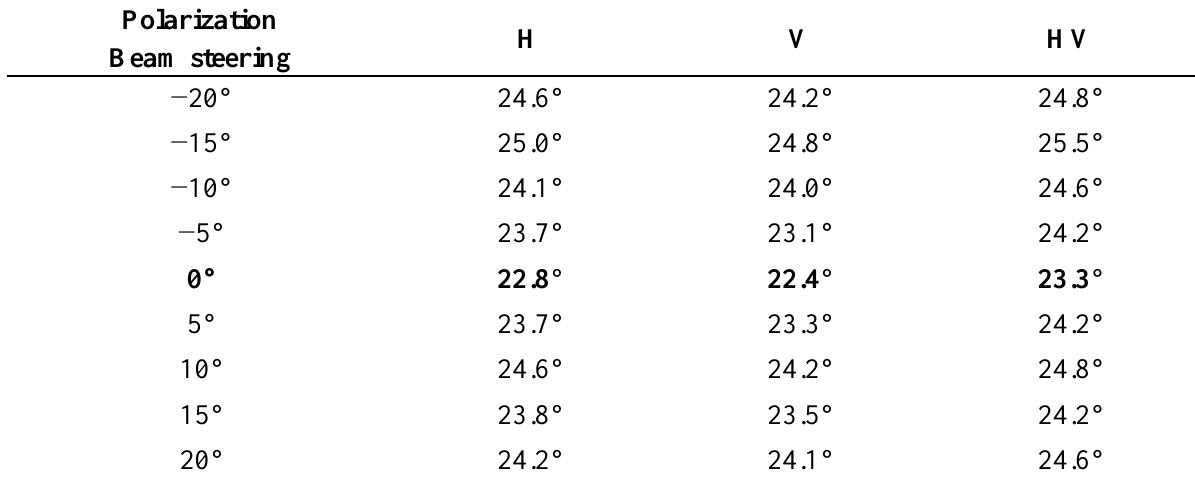
Table 2.  for the synthesized −3dB